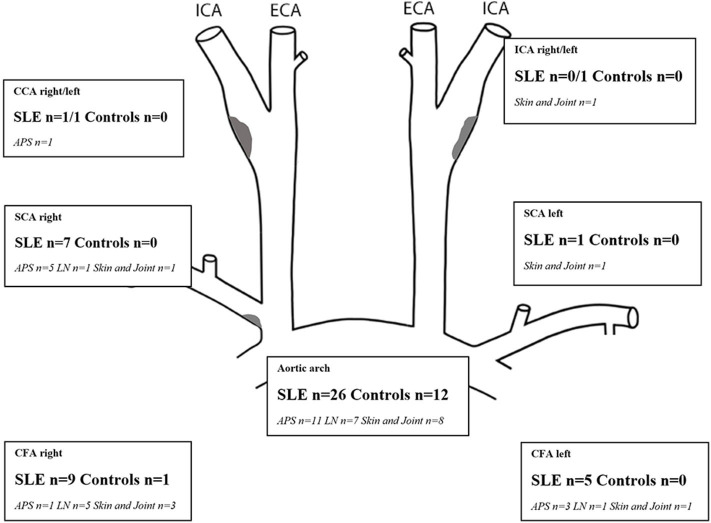
Number of SLE patients with each phenotypic subgroup and controls with areas showing increased IMT (≥0.9 mm for CCA, ICA, SCA, CFA; ≥1.2 mm for the aortic arch). Plaques (gray areas) were distributed as follows: right/left carotid bifurcation: SLE, n = 9/5; controls 2/2, proximal SCA right SLE, n = 2, CFA right/left SLE, n = 3/1. APS, antiphopholipid syndrome; C, controls; CCA, common carotid artery; CFA, common femoral artery; ICA, internal carotid artery; IMT, intima-media thickness; LN, lupus nephritis; mm, millimeter; SCA, subclavian artery; SLE, systemic lupus erythematosus.